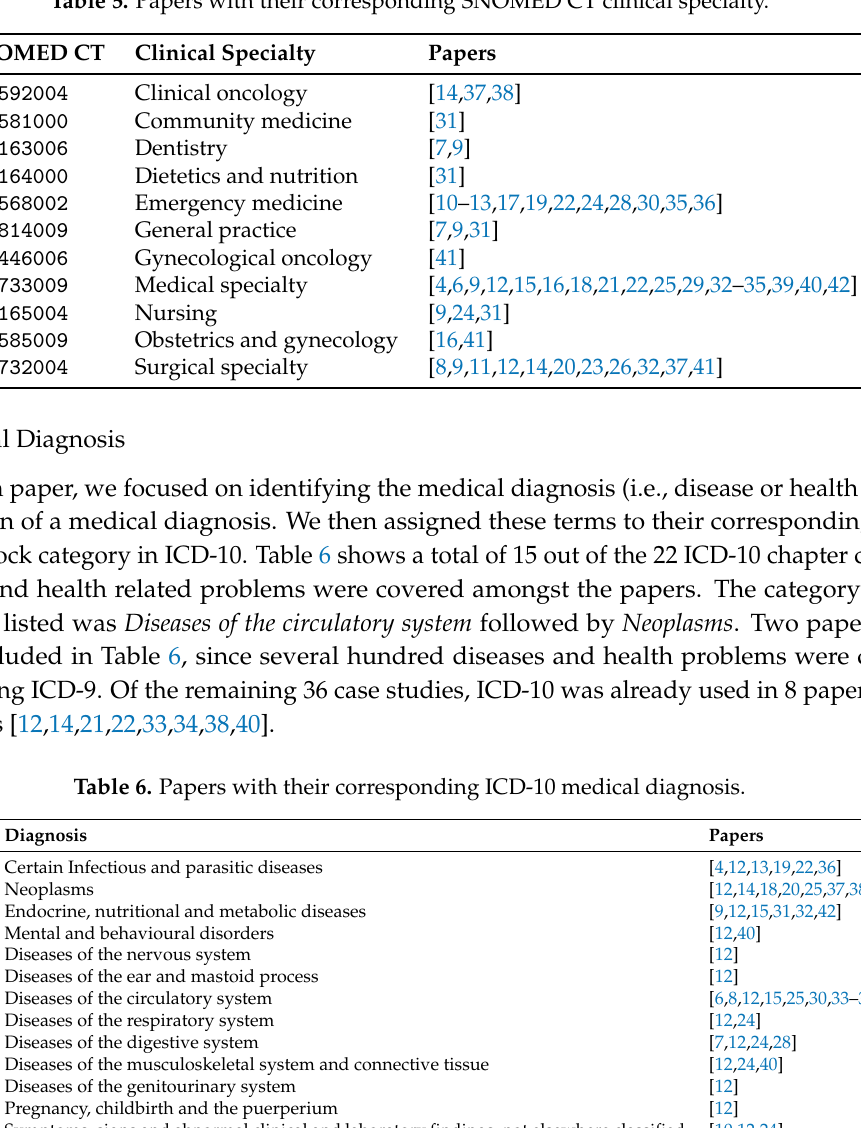
Table 5. Papers with their corresponding SNOMED CT clinical specialty.